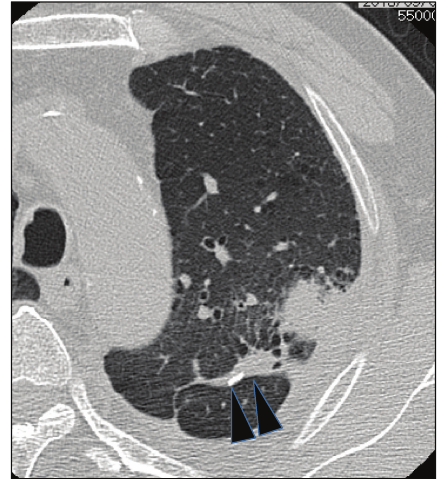
Figure 2: Chest CT reveals a 30 mm pulmonary nodule close to the initial surgical margin